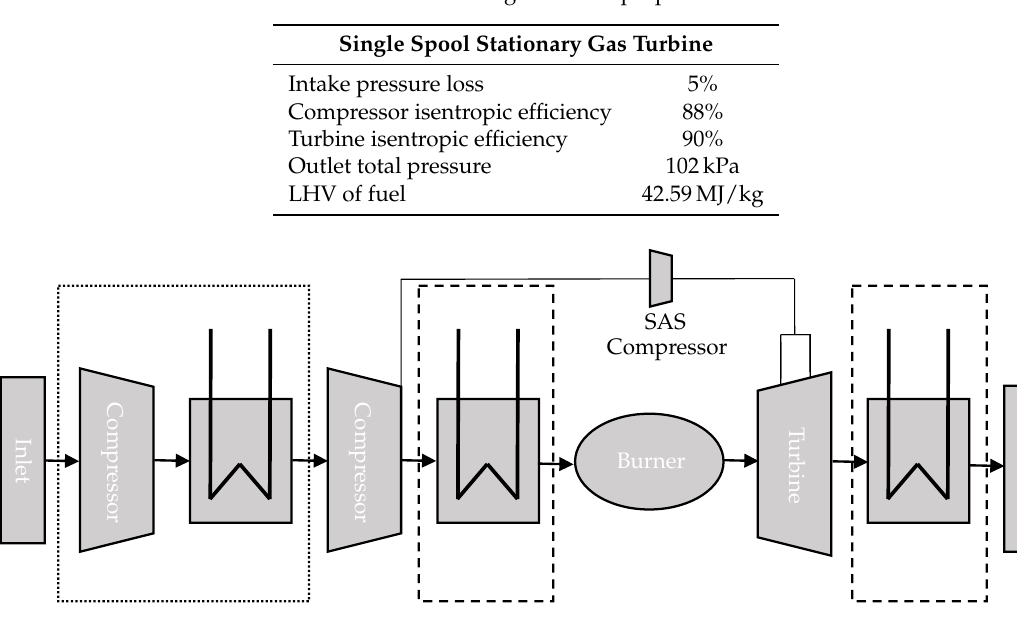
Figure 1. Gas turbine model for the simple, intercooled (including the dotted line), recuperated (including the dashed line), and intercooled-recuperated cycle (including the dotted and dashed